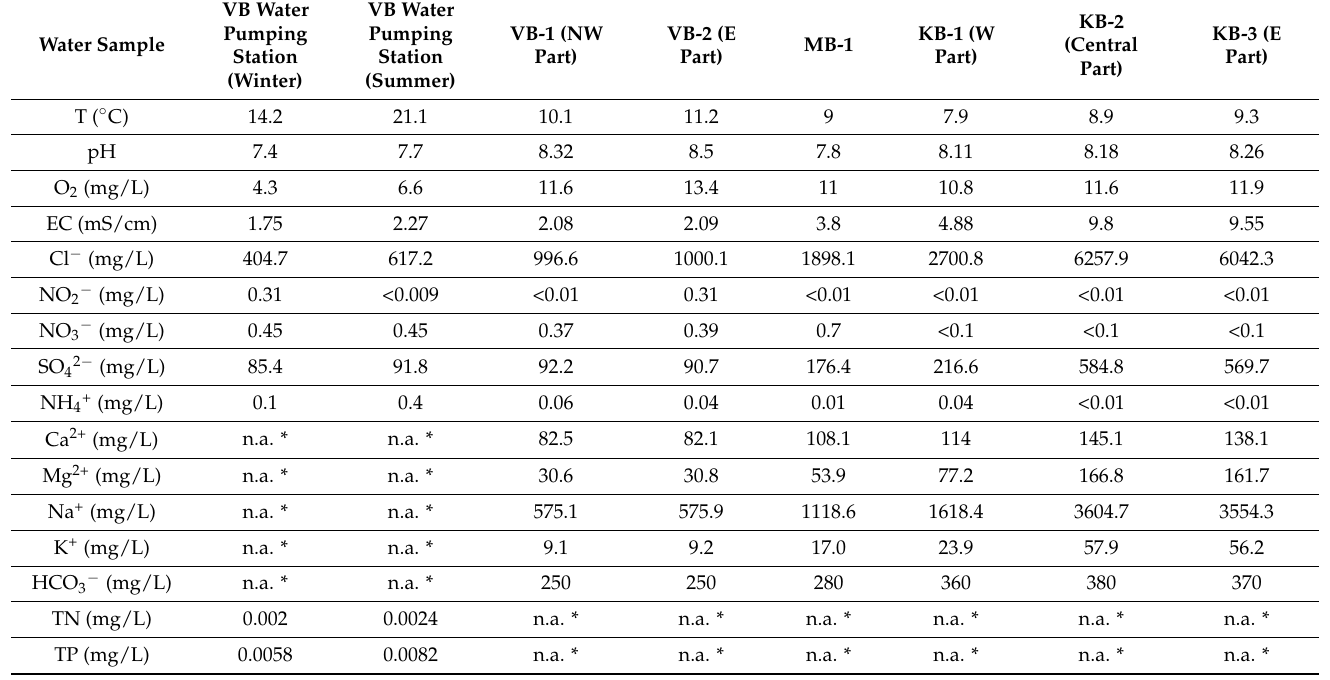
Table 1. Groundwater characteristics and geochemistry from the water pumping station of Velo Blato (VB), measured between 2016 and 2018, and presented as winter (November–May) and summer (July–October) periods; and surface water samples from Velo (VB), Malo (MB), and Kolanjsko (KB) Blato, measured in this